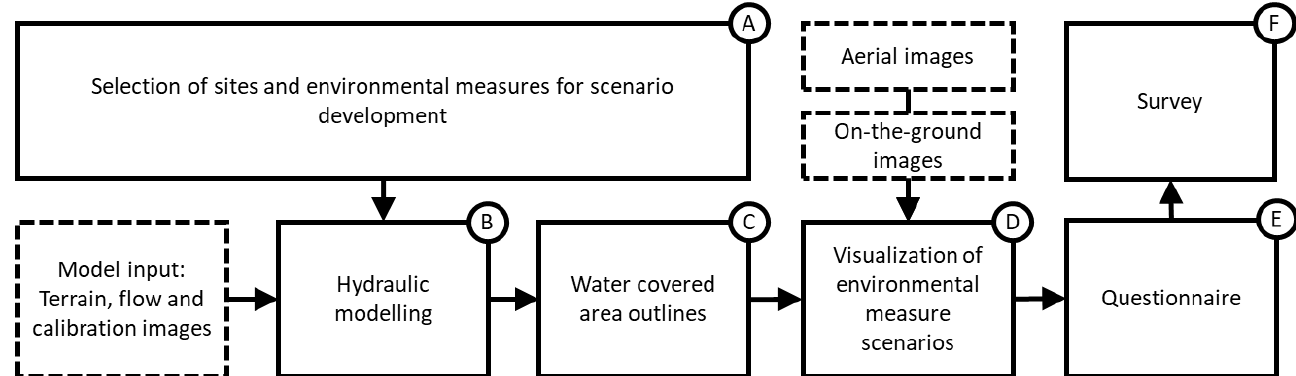
Figure 2. Method outline. ( A ) Selection of sites and environmental measures for scenario development, ( B ) hydraulic modeling of the scenario-based water-covered area, ( C ) outlines of the water-covered area in different environmental measures scenarios, ( D ) visualization of scenario images based on outlines and two sets of image acquisition types, and ( E ) the resulting questionnaires with weir scenario images as an input for ( F ) the survey.